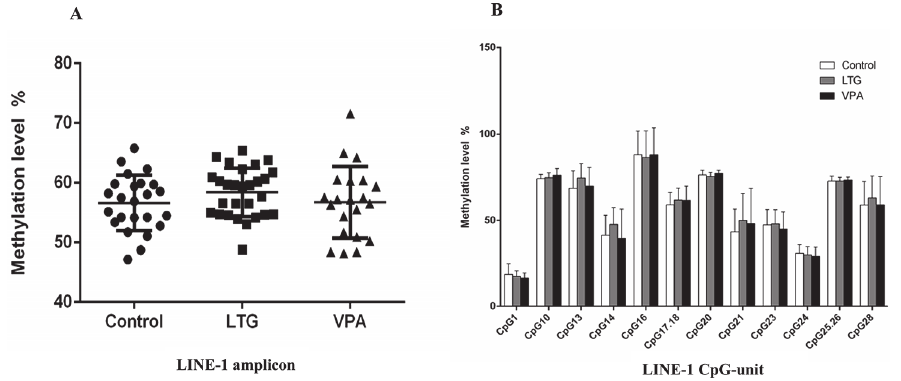
Fig 2. A Methylation levels of LINE-1 among the control, LTG and VPA groups. B Methylation levels of informative CpG units in LINE-1 among the control, LTG and VPA groups. * P < 0.05. Abbreviations : LINE-1 : long interspersed nucleotide element-1; LTG: lamotrigine; VPA: